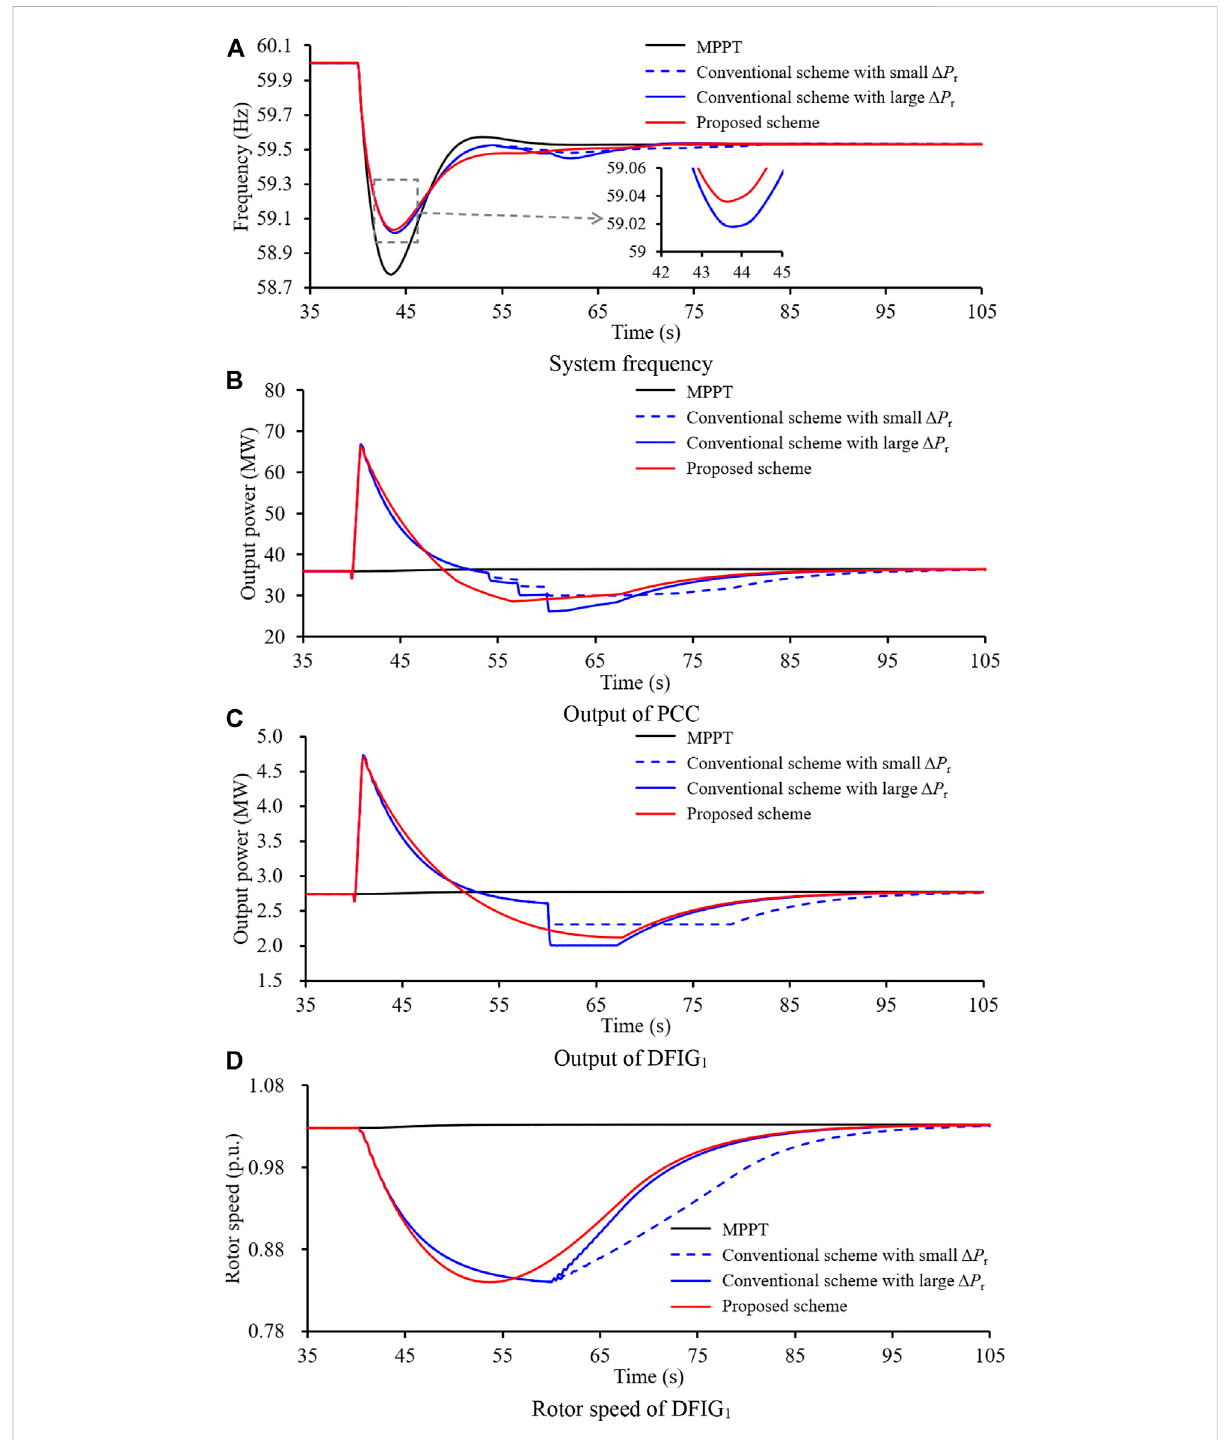
Results for case